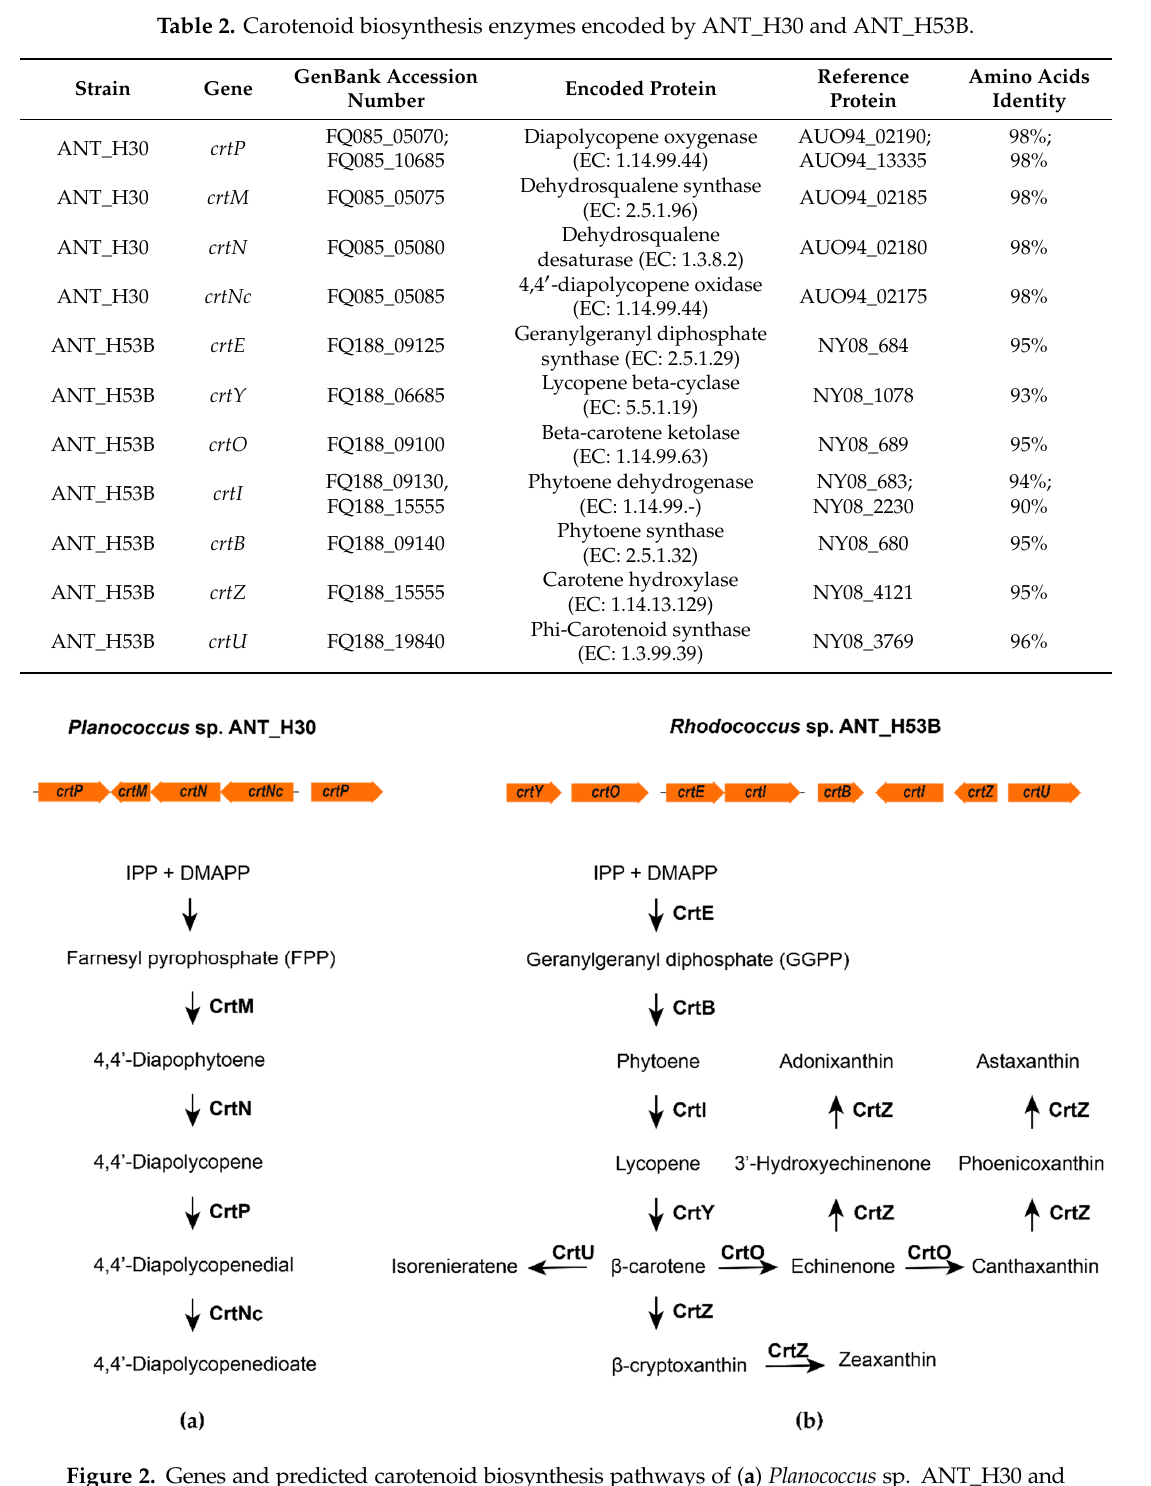
Figure 2. Genes and predicted carotenoid biosynthesis pathways of ( a ) Planococcus sp. ANT_H30 and